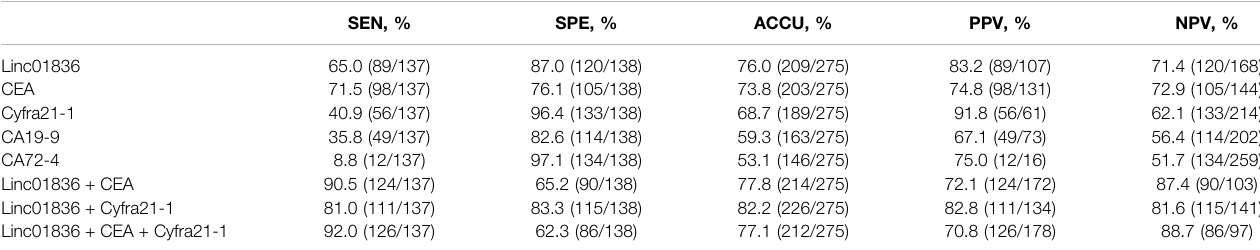
TABLE 5 | Independent or joint diagnostic value of Linc01836 and other commonly used tumor biomarkers for distinguishing CRC patients from healthy population. SEN, % SPE, % ACCU, % PPV, % NPV,